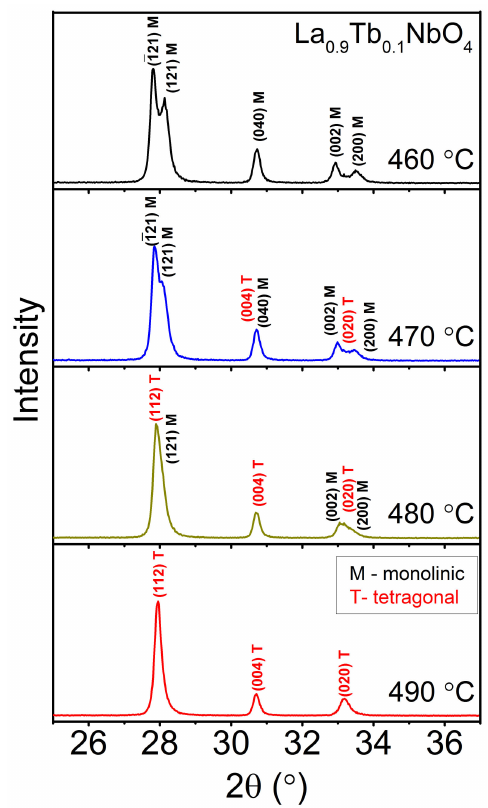
Figure 3. HTXRD patterns of La 0.9 Tb 0.1 NbO 4+ δ . Reflections of monoclinic and tetragonal phases were indexed with “M” and “T” letters,